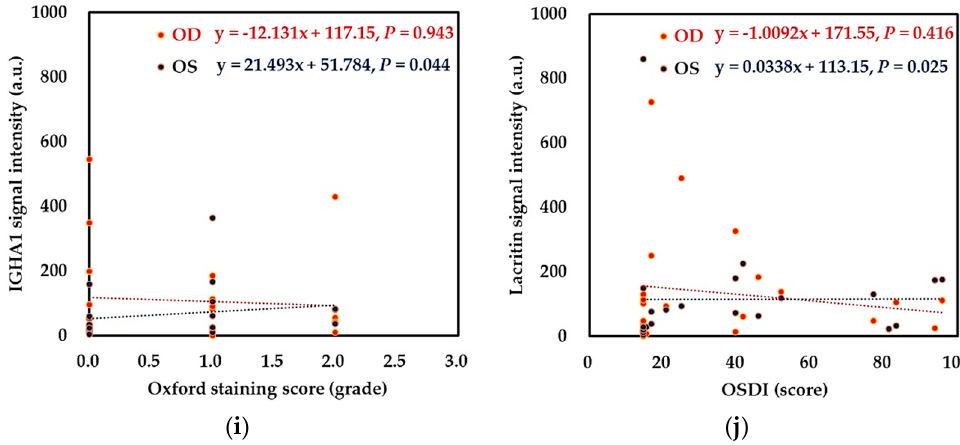
Figure 7. Concordant and discrepant binocular associations between ocular surface homeostatic markers and tear biomarkers in dry eye patients ( N = 23). ( a , b ) concordant binocular associations; ( c – f ) concordant binocular trends; and ( g – j ) discrepant binocular trends. Abbreviation: NIKBUT_f, non-invasive keratographic first break-up time; IGHA1, immunoglobulin alpha-1 chain C region; and OSDI, ocular surface disease index.